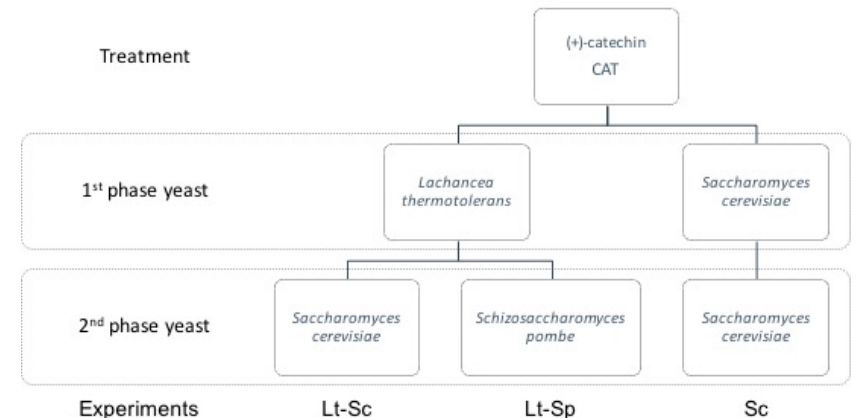
Figure 3. EXperimental design for CAT treatment. Three different trials named Lt-Sc, Lt-Sp and Sc resulted from the combination of 1st and 2nd phase yeast. The other treatments assessed (PB2, PC1, and PA2) followed the same design.